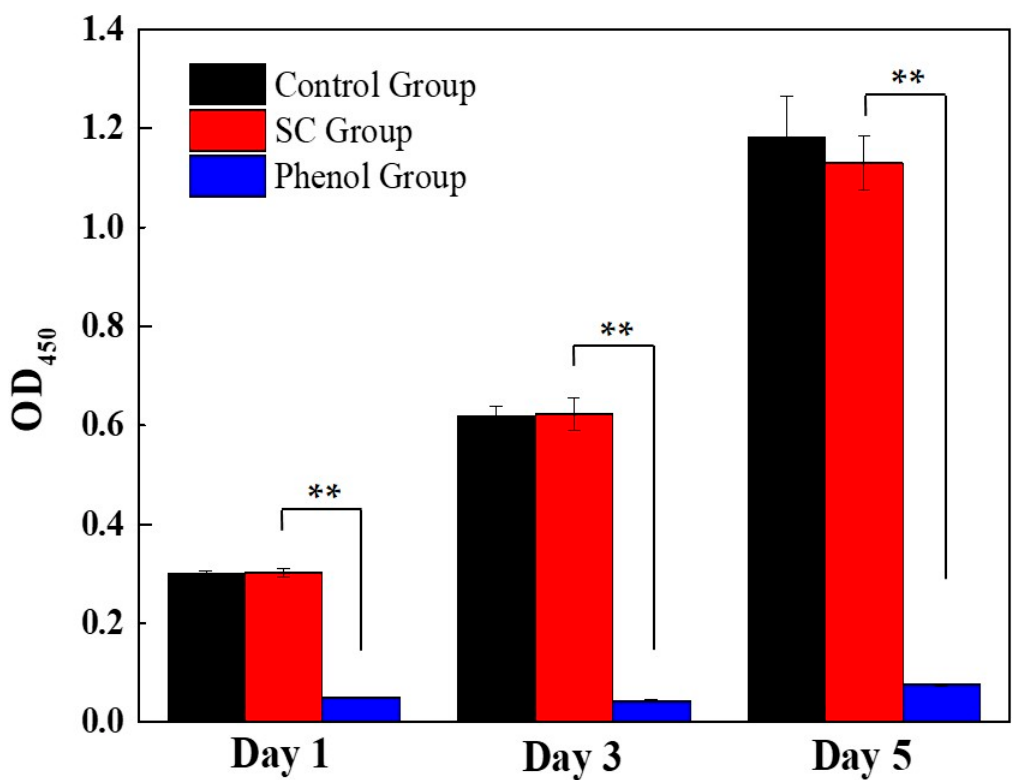
Figure 6. Toxicological effect of SC1050 on HEK-293 cells. (n = 3, ** p < 0.01).